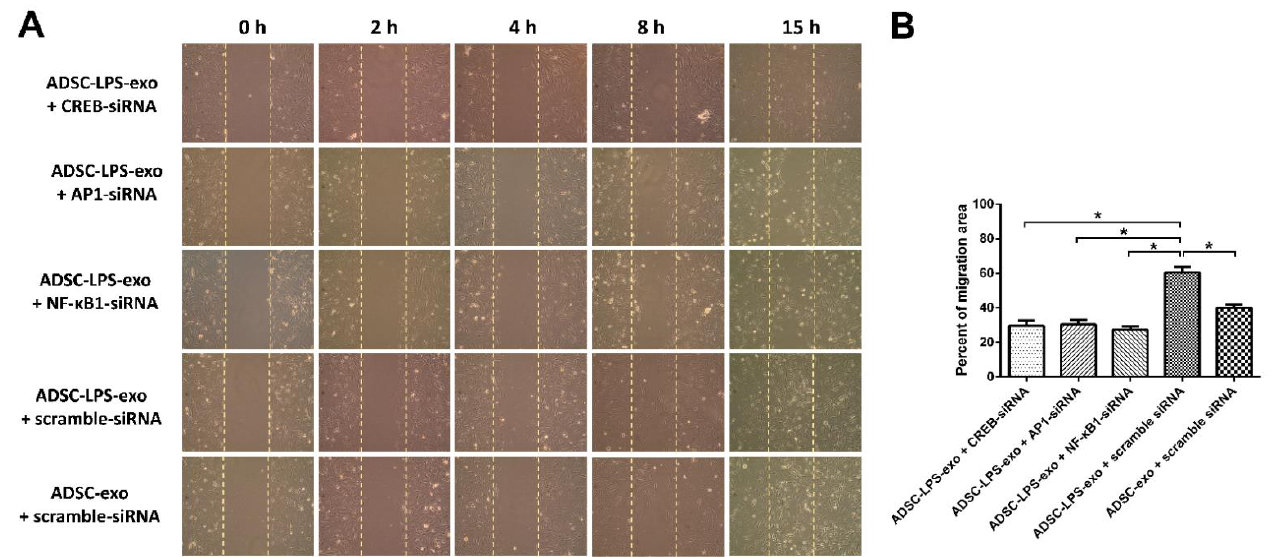
Figure 5. ( A ), Cell migration into the gap created by Culture-Inserts in the culture plate coated with 1% gelatin for HUVECs transfected with 10 nM siRNA-CREB, siR-NA-AP-1, siRNA-NF- κ B1, or scramble siRNAs. The silicone insert was carefully removed 24 h later, leaving a 500 µ m cell-free gap. Thereafter, 30 µ g ADSC-exo or ADSC-LPS-exo was added to the wells. An Olympus CKX41 microscope (Olympus) was used to capture the migration distance of cells to the cell-free zone at 0, 2, 4, 8, and 15 h. Image J was used to calculate the area of migration of cells. ( B ), The bar plot indicates the percentage of migration area of the gap measured at 8 h following exosome treatment. n = 6 for each condition. (*, a p -value < 0.05 with at least a 2-fold difference).